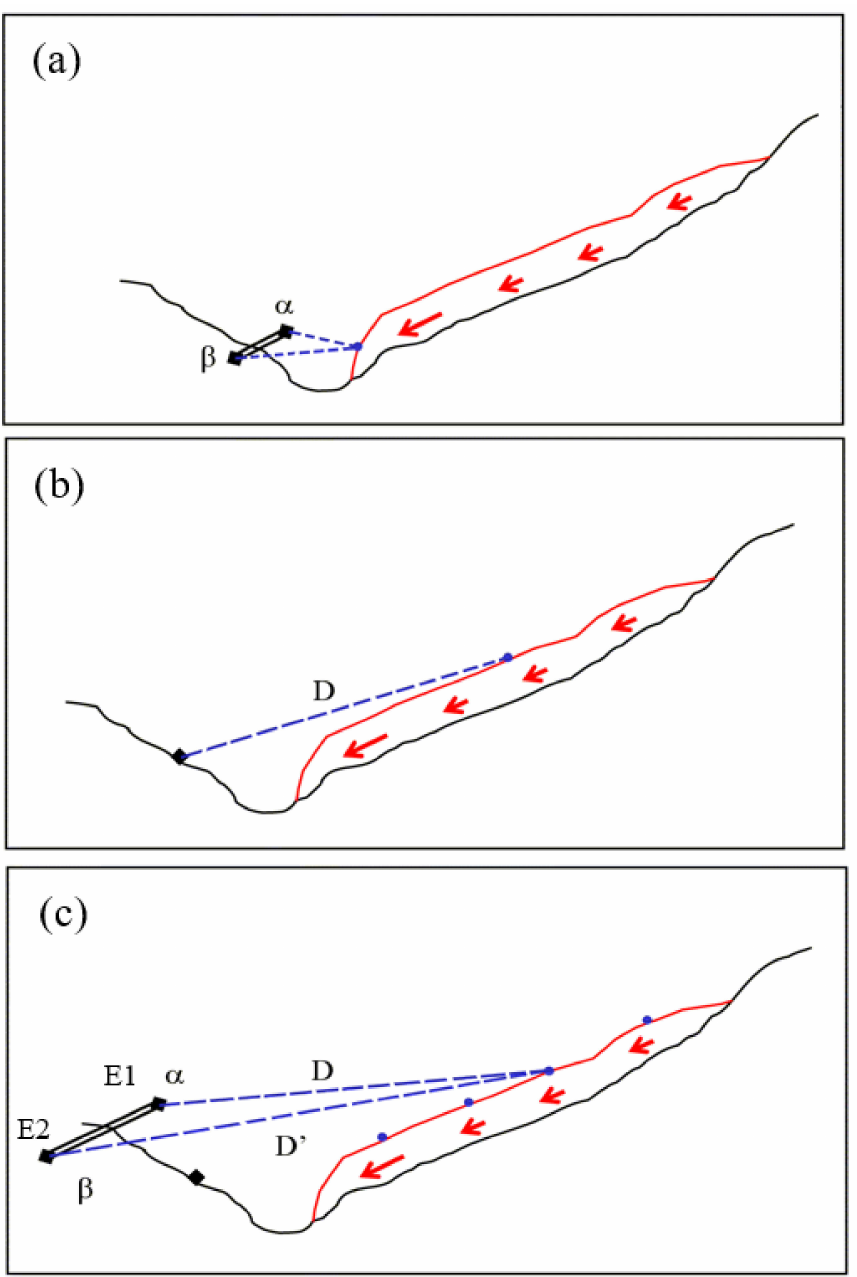
Figure 6. Schemes for the triangulation ( a ), single distance variation ( b ) and triangulateration ( c ) methods as used in the Vallcebre landslide from 1987 to